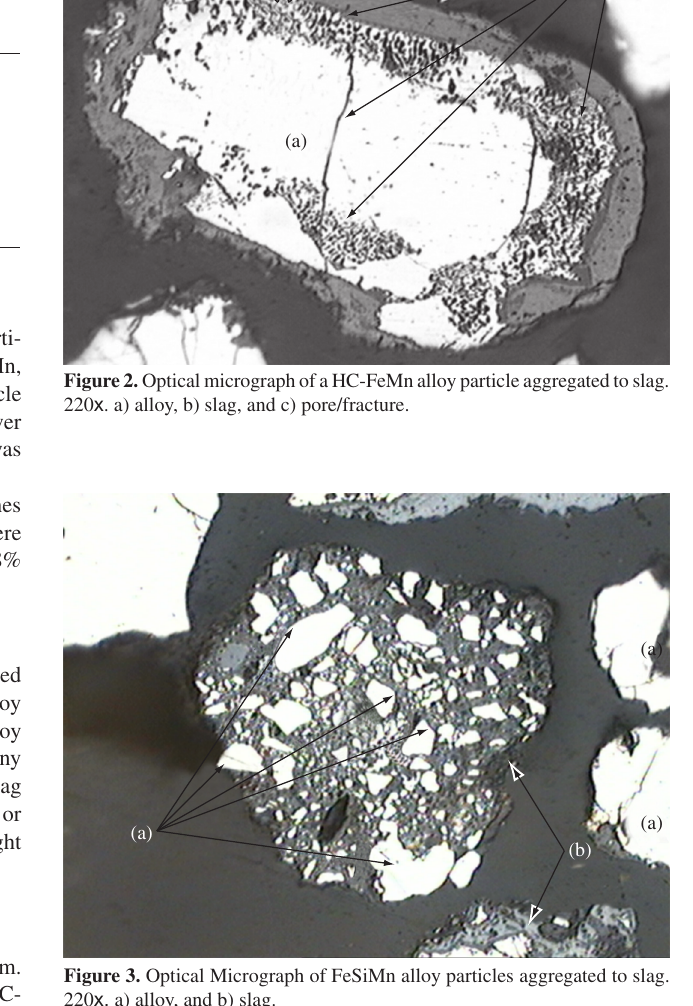
Table 4. Quantitative analysis of HC-FeMn fines for slag and alloy content and the slag liberation fractions as a function of particle size. Particle size